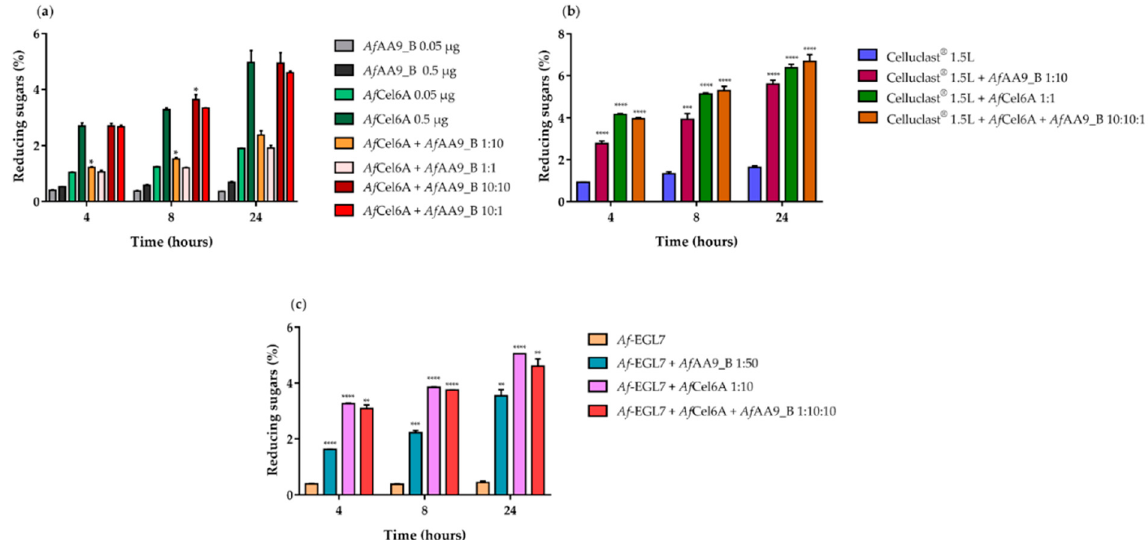
Figure 7. Synergistic action on 1% ( w/v ) CM-Cellulose of ( a ) Af Cel6A and Af AA9_B; ( b ) Af Cel6A, or Af AA9_B, or both with Celluclast ® 1.5 L cocktail; and ( c ) Af Cel6A, or Af AA9_B, or both with Af -EGL7. All reactions were incubated in 50 mM sodium phosphate buffer (pH 6.0) at 1000 rpm and 50 °C for 4, 8, or 24 h. At the end of each reaction, the measured reducing sugars were plotted as a function of the relative proportions among the added enzymes. Asterisks indicate significant difference ( p < 0.05) in relation to the control system ( Af Cel6A, Af -EGL7, or cocktail alone).